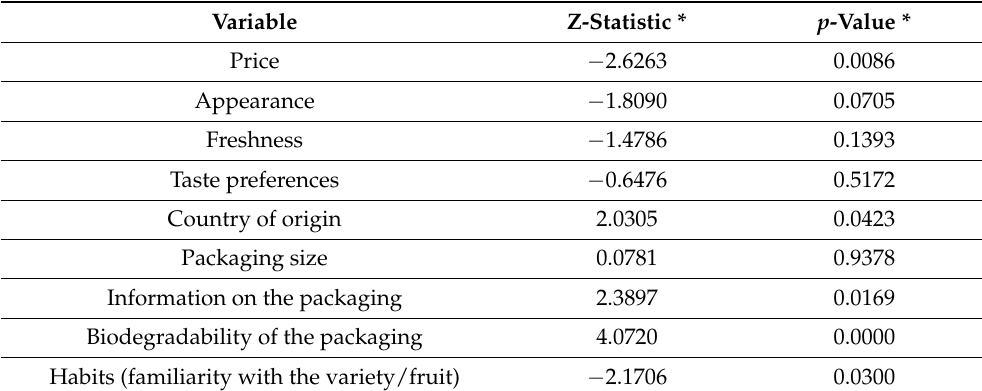
Table 5. Variations in significance of selected features of fruit and fruit preserves for innovators and non-innovators.